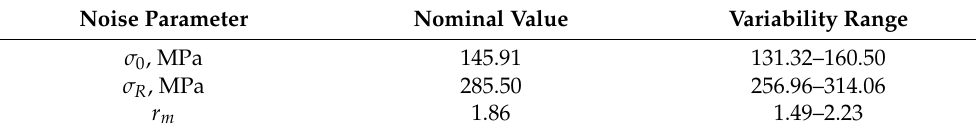
Table 3. Noise parameters, nominal values, and variability